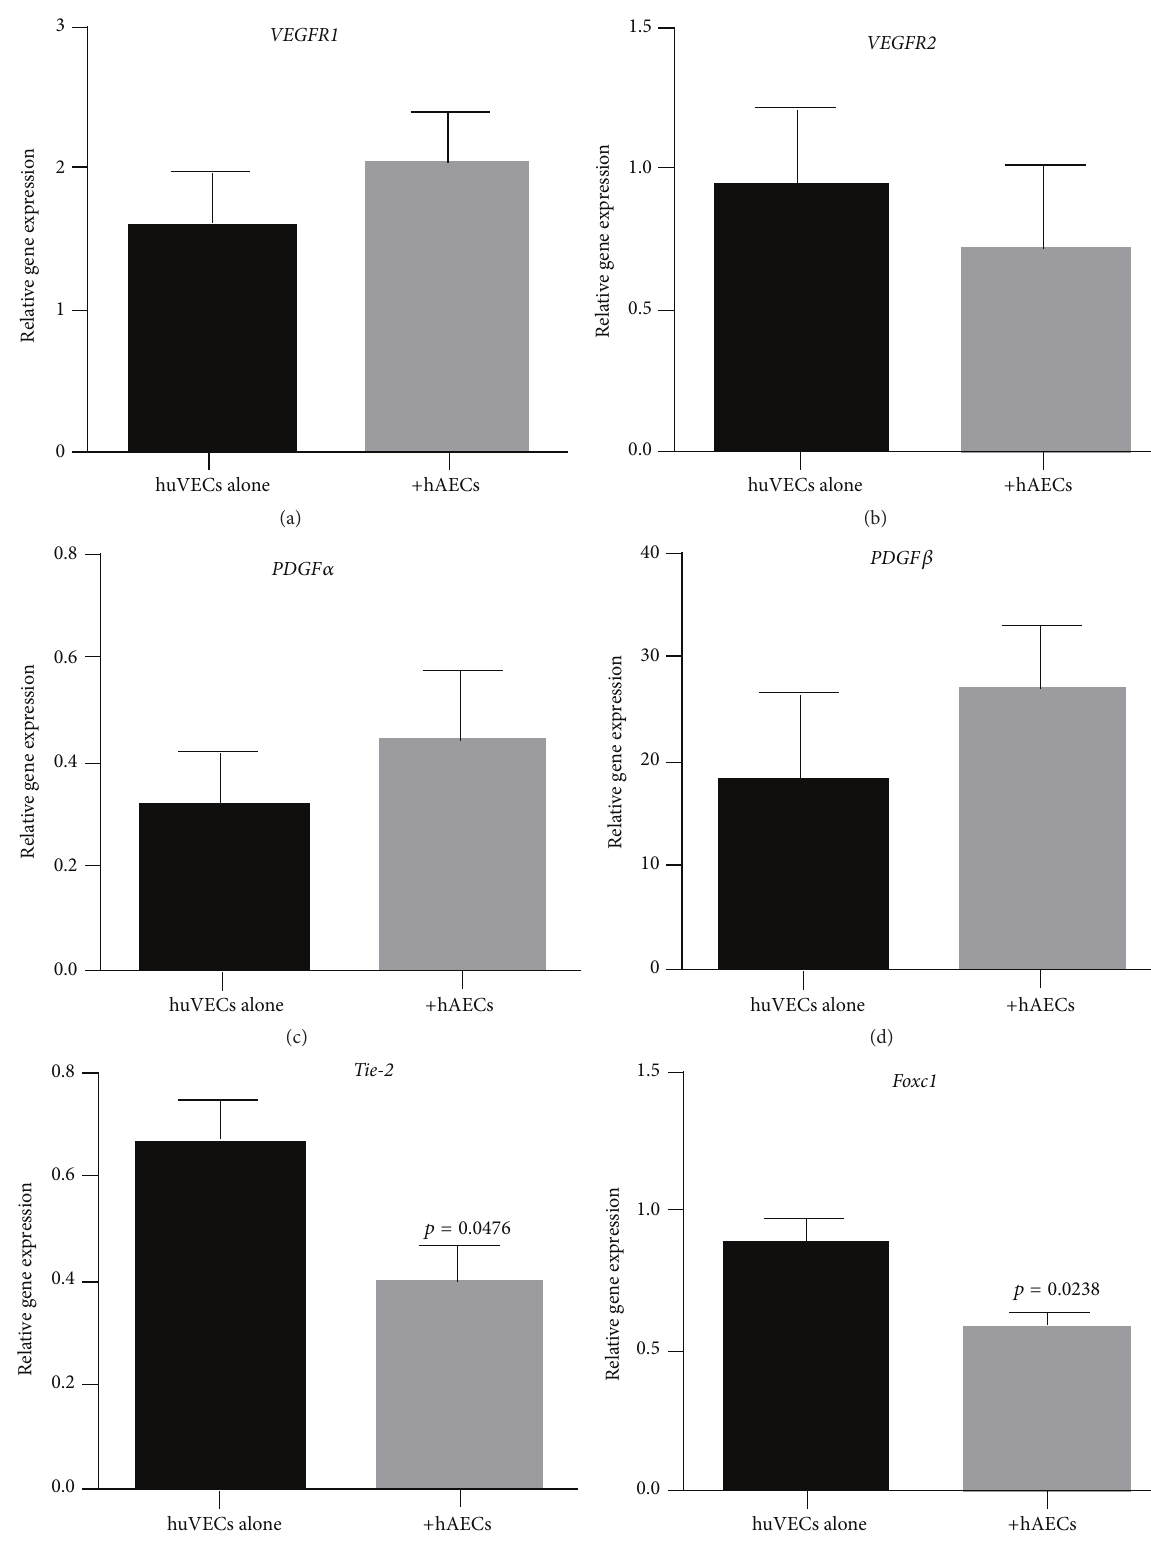
Figure 4: Gene expression of angiogenic factors by huVECs cocultured with term hAECs in the presence of TNF 𝛼 and IFN 𝛾 . ((a)–(d)) There was no change in gene expression of VEGFR1 , VEGFR2 , PDGFR 𝛼 , and PDGFR 𝛽 , ((e) and (f)) while gene expression of Tie-2 and FOXC1 was significantly reduced ( 𝑝 = 0.0476 and 𝑝 = 0.0238 ,